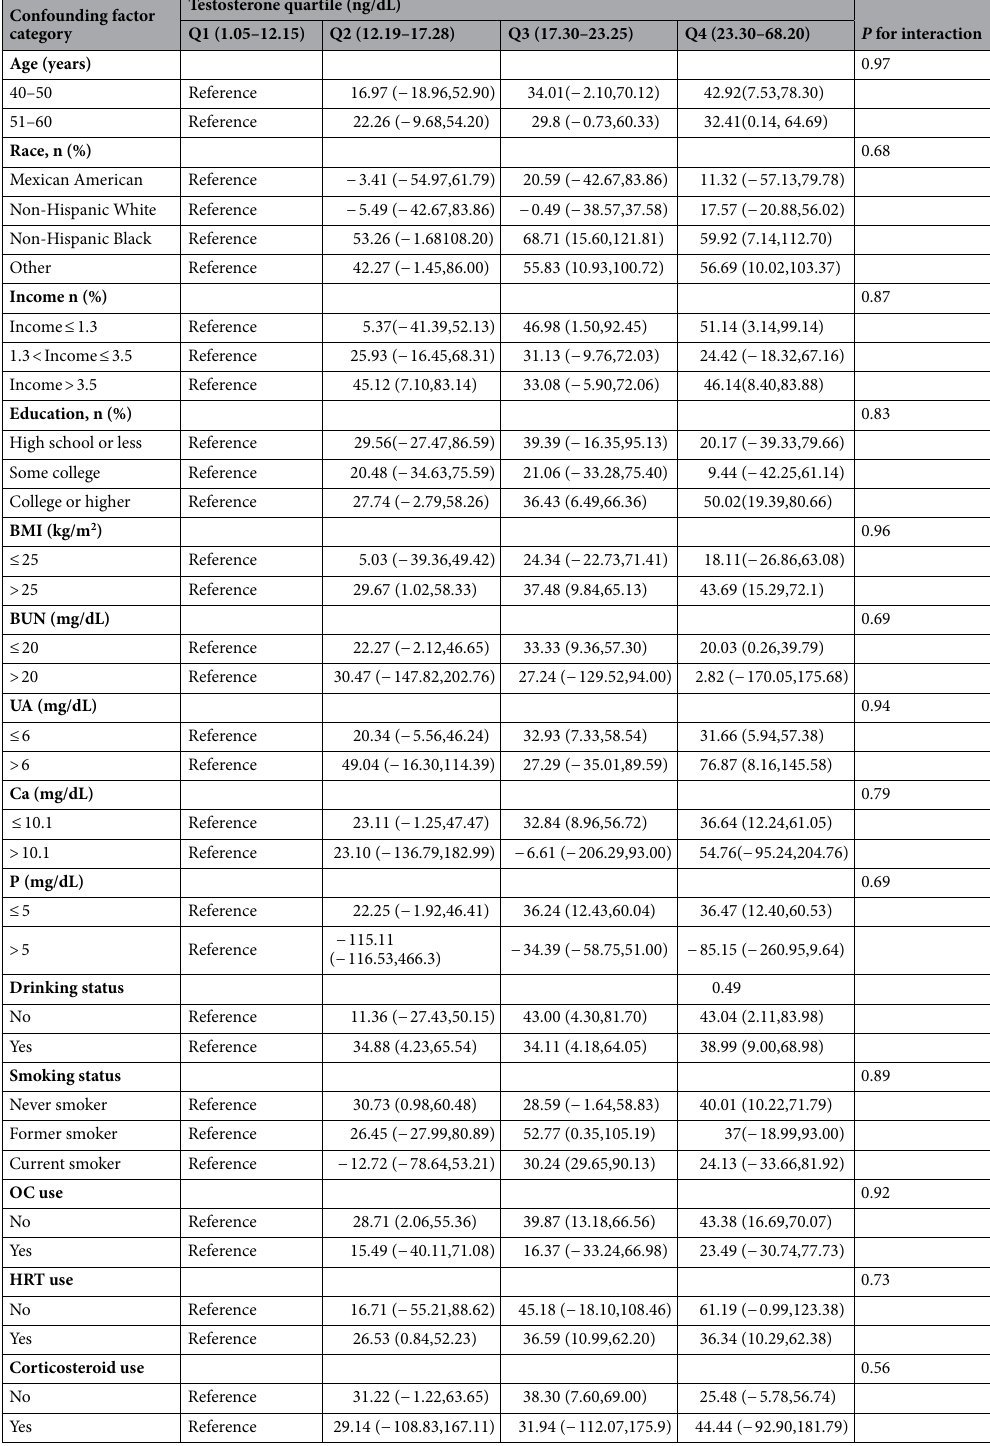
Table 4. Subgroup analyses of the association between testosterone levels and lumbar BMD. Adjusted for age, race, BMI, education level, income level, blood urea nitrogen levels, serum uric acid levels, serum calcium levels, serum phosphorus levels, smoking status, drinking status, ever taking birth control pills, ever using female hormones, and ever using corticosteroids. A P for interaction > 0.05 represents no